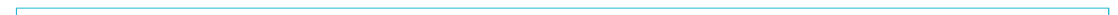
Figure 1: Representative sagittal and axial T2w images are shown (a: patient 1, 9.3-year-old old boy; b: patient 2, 7.1-year-old girl) as well as T1w images with and without contrast agent (b). Cervical myelitis with increased T2 signal is present in both children (arrows), in the boy only in the cervical spinal cord (a), in the girl additionally in the lumbar spinal cord (b). On the axial slice predominant involvement of the grey mat- ter is evident (arrows point to anterior horns). In b (second column) sagittal T1w images show enhancement of the cauda equina and anterior nerve root enhancement (arrow heads).